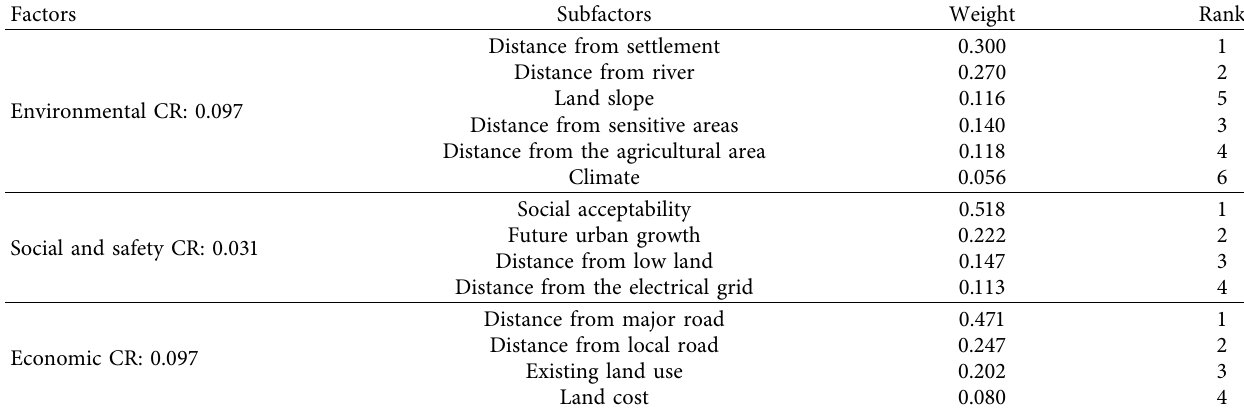
Table 7: The weights distribution on each subfactor division.